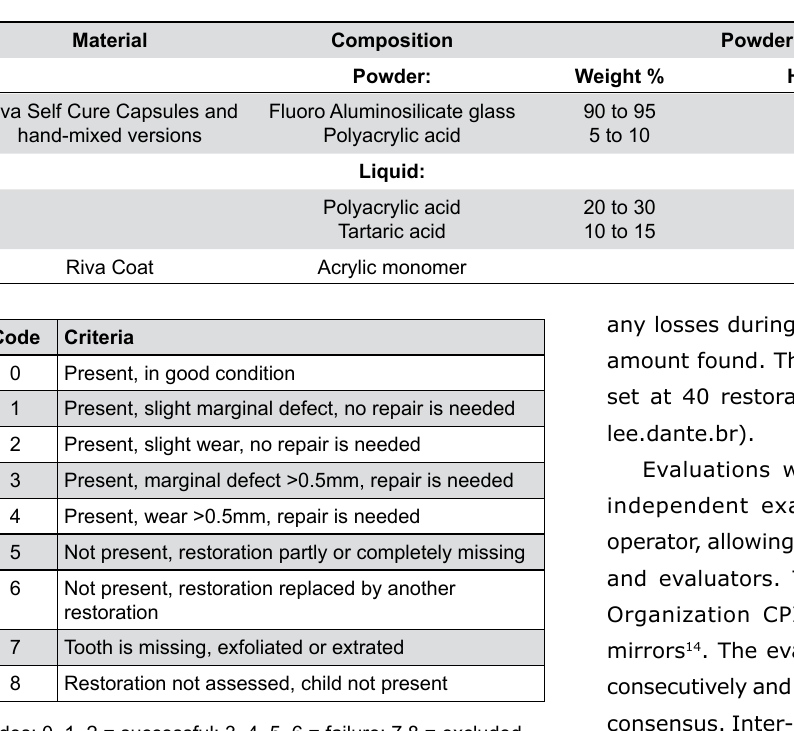
Table 1- Chemical composition of glass ionomer cements(GICs)